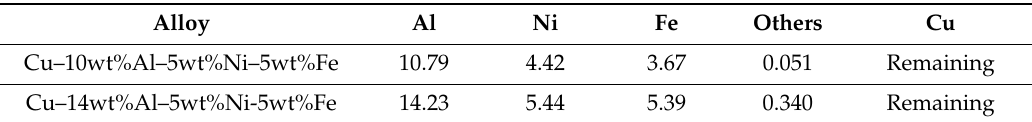
Table 1. Chemical composition of ingots in